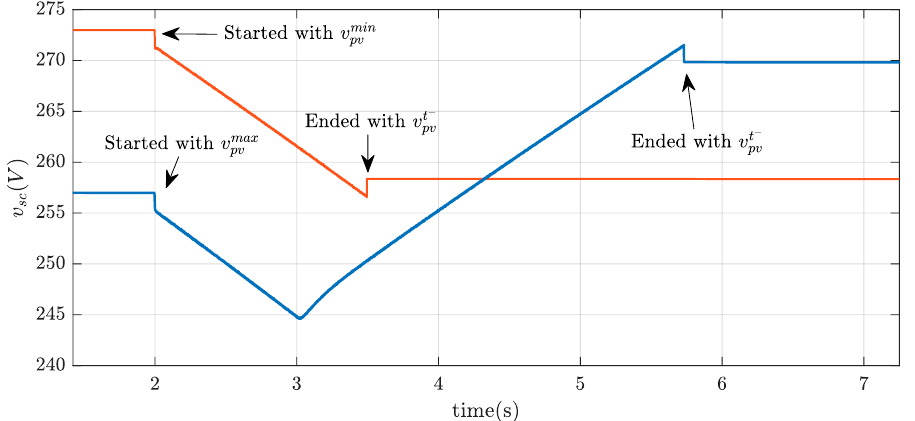
Figure 22. SCterminal voltage during the changeover between PV and SC; v t − pv refers to the PV Figure 22. SC terminal voltage during the changeover between PV and SC; Figure 22. SC terminal voltage during the changeover between PV and SC; voltage at the changeover moment. voltage at the changeover moment. voltage at the changeover